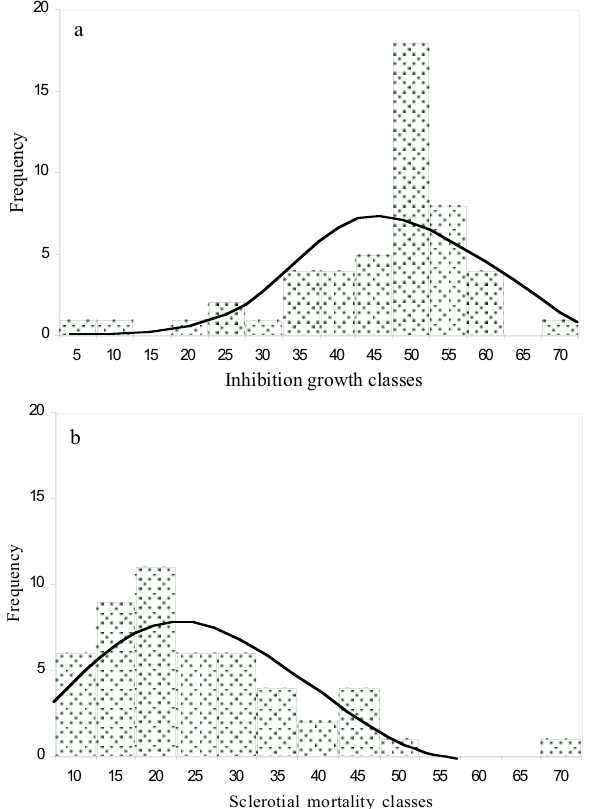
Fig. 1. Distribution of the frequency of T. harzianum isolates from Doukkalla region, according to: a, myceli- al growth inhibition of S. rolfsii on PDA dishes; b, an- tagonistic action on sclerotia of S. rolfsii in the